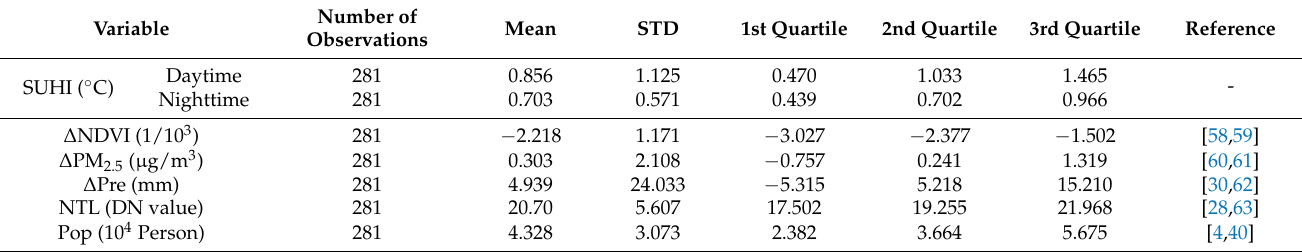
Table 1. Descriptive statistics for variables in this study.